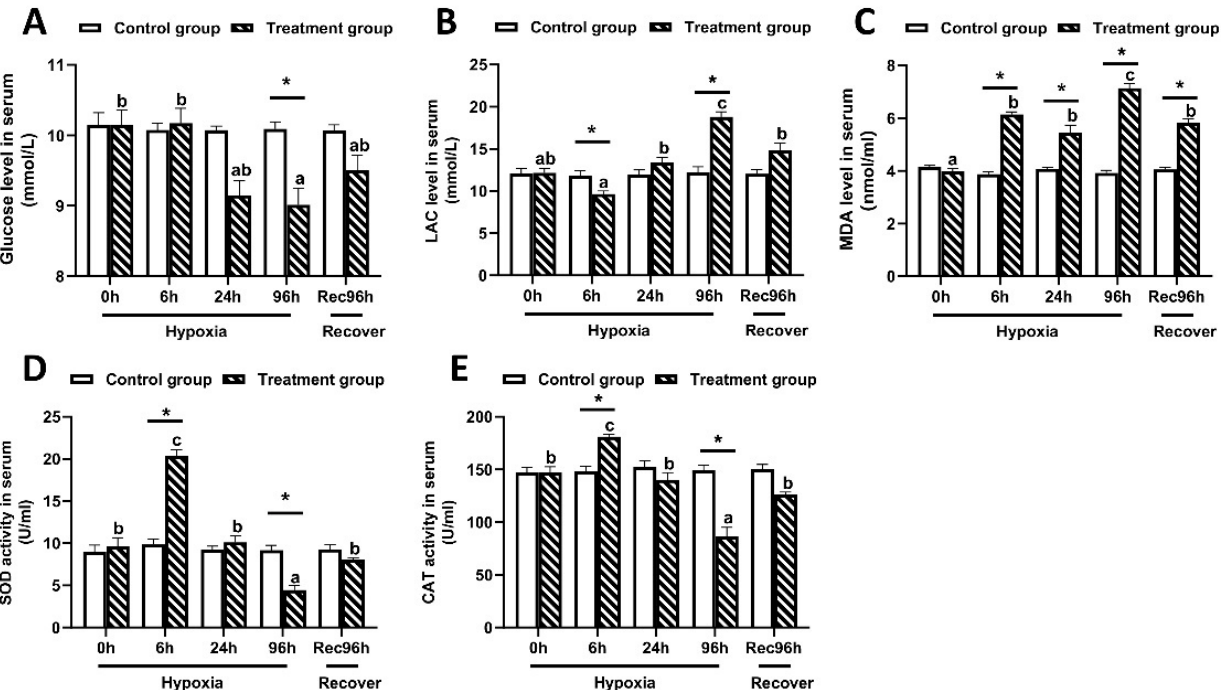
Figure 2. Serum biochemical indices of largemouth bass under 96 h of hypoxic stress and recovery for 96 h ( n = 12). ( A ): Glucose concentration. ( B ): Lactic acid concentration. ( C ): Malondialdehyde (MDA) content. ( D ): Superoxide dismutase (SOD) activity. ( E ): Catalase (CAT) activity. Different letters above bars indicate significant differences among sampling times. Asterisks indicate signifi- cant difference between control group and hypoxia treated group at each time point.